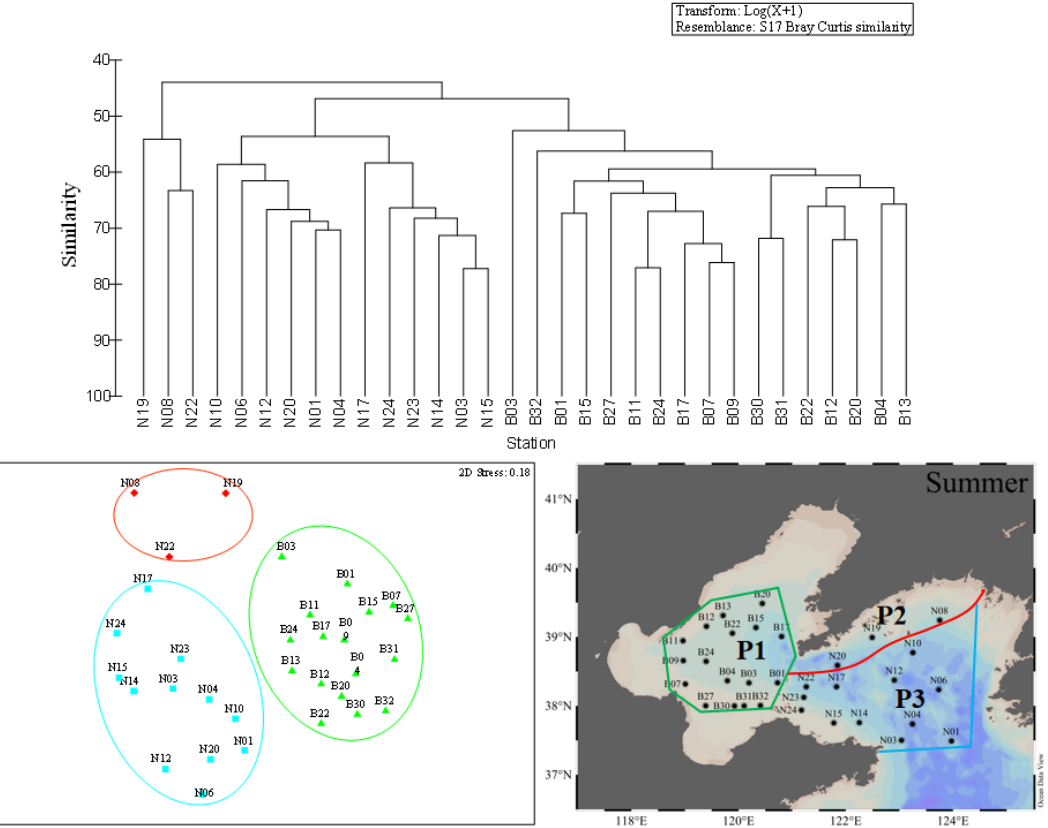
Figure 6. Cluster analysis (left) and MDS (right) of the top 15 dominant species at each station in summer. Each symbol represents a sampling station: green triangles = fourth assemblage; blue squares = fifth assemblage; red diamonds = sixth assemblage.